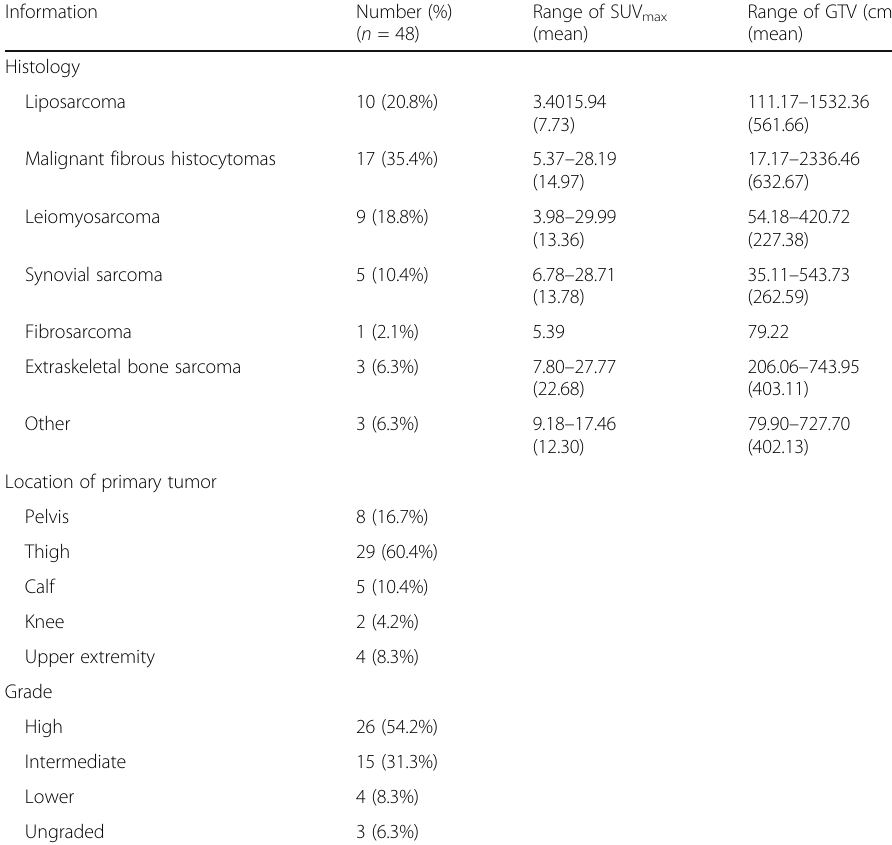
Table 1 Tumor characteristics